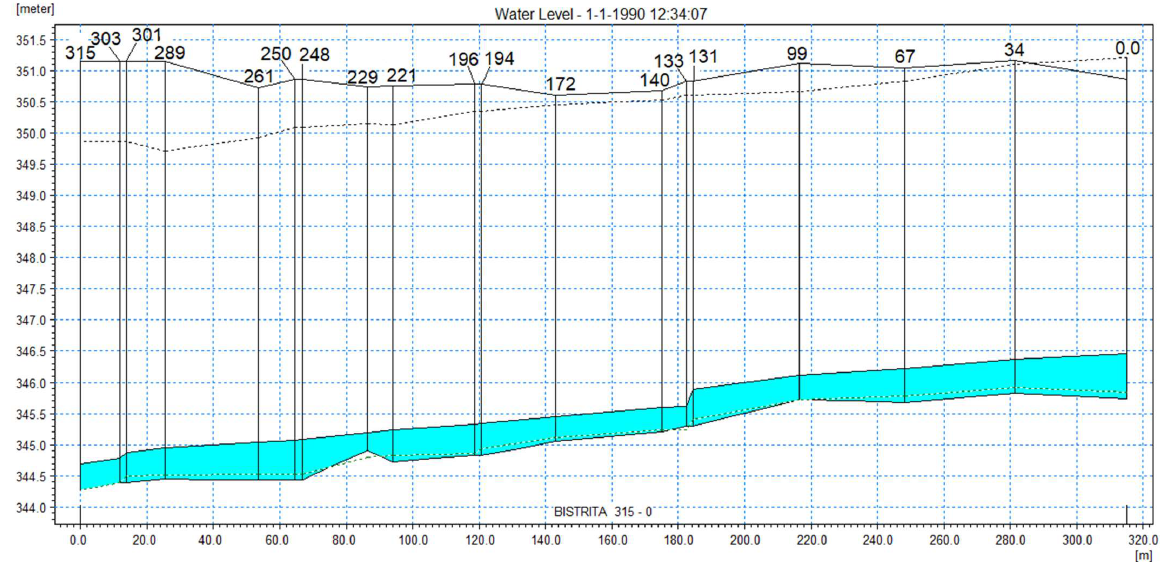
Table 2. The depth and velocity of the water in each cross-section for all simulated flows. For the case where there is only one weir, the existing one.